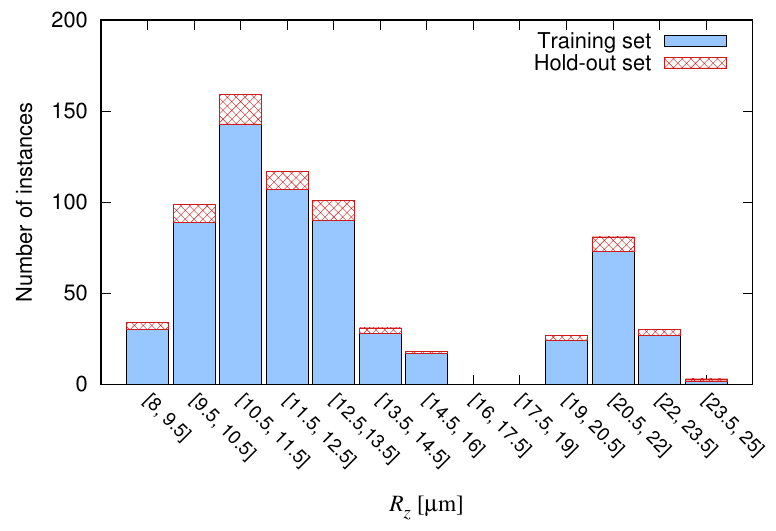
Figure 2. Distribution of instances with respect to the value of R z